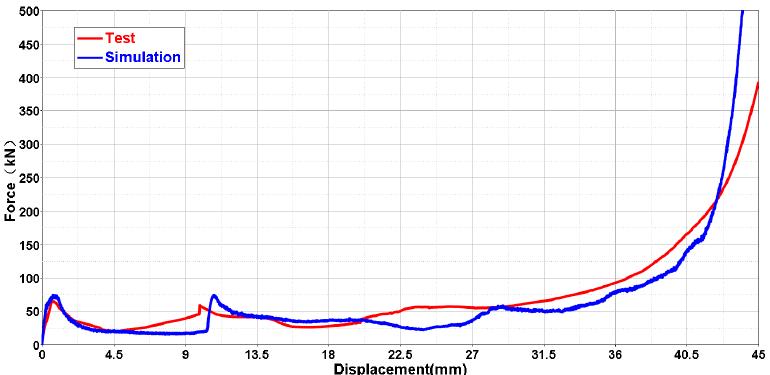
Figure 21. Comparison of the force-displacement curves of the NPR structure (Type C, 24 cells per layer, 4 layers, α h = 0.5, α l = 1, h 2 = 20 mm, r 1 = 0 mm, r 2 = 0.8 mm).